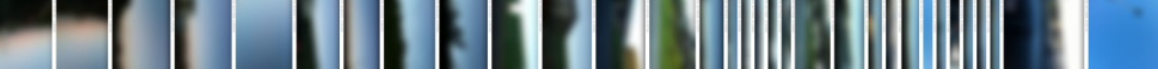
Fig. 9. CitySkin image output: driving for 34